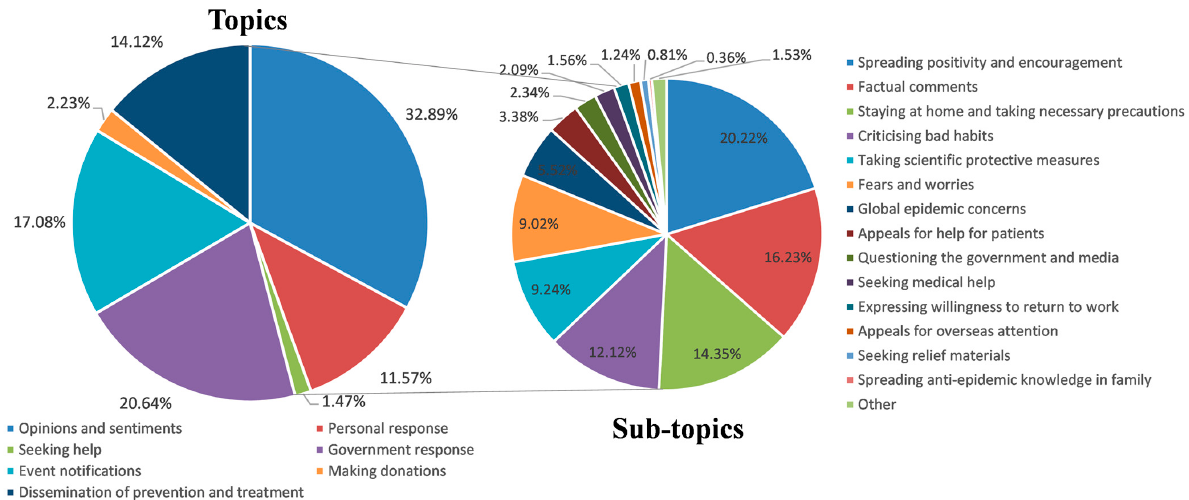
Figure 6. Classification of topics and sub-topics extracted from Weibo texts relevant COVID-19.